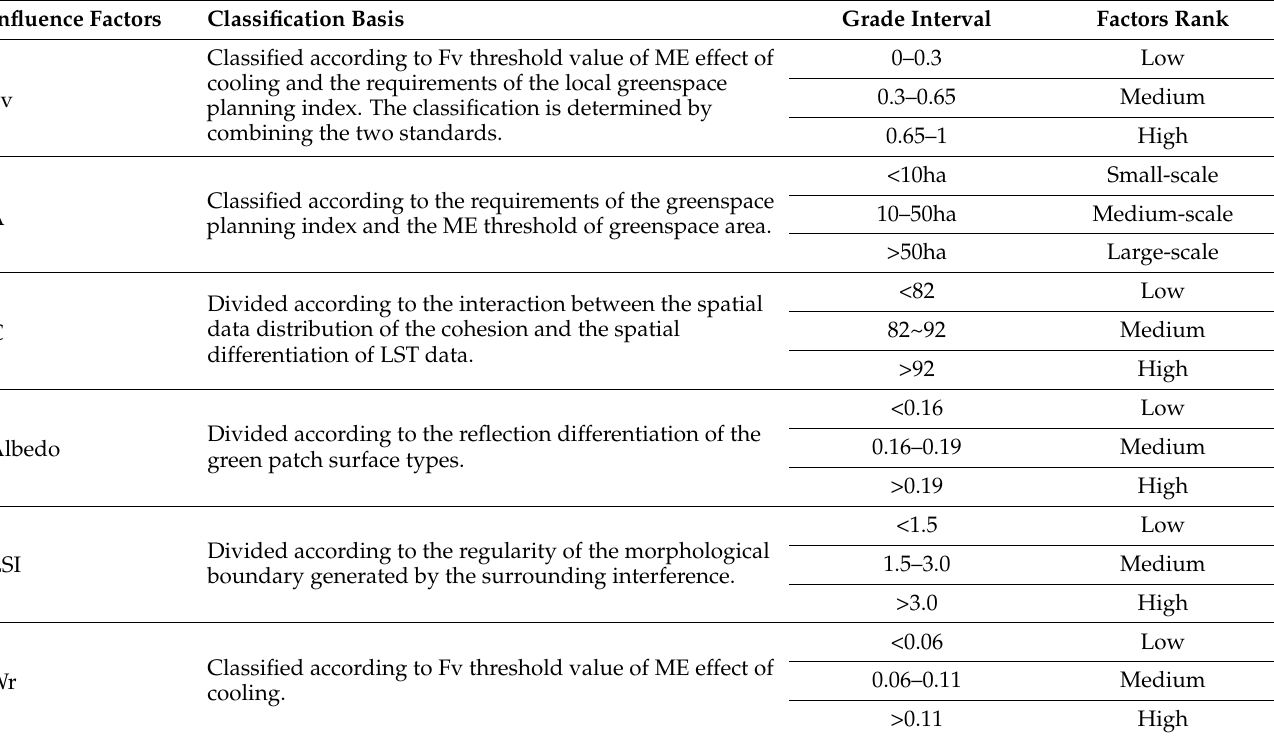
Table 3. Classification of conventional spatial quantitative factors of